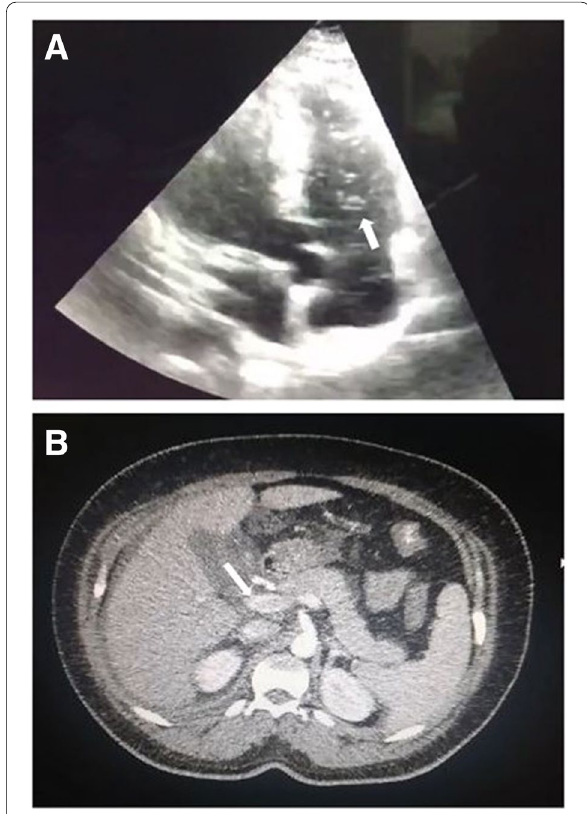
Fig. 1 Diagnostic Images performed. A Transthoracic echocardiogram showing the presence of bubbles in the right chambers (white arrow). B Contrast-enhanced abdominal tomography showing acute non-cirrhotic portal vein thrombosis: partial enhancement of the portal vein, showing an image compatible with a thrombus inside (white arrow)